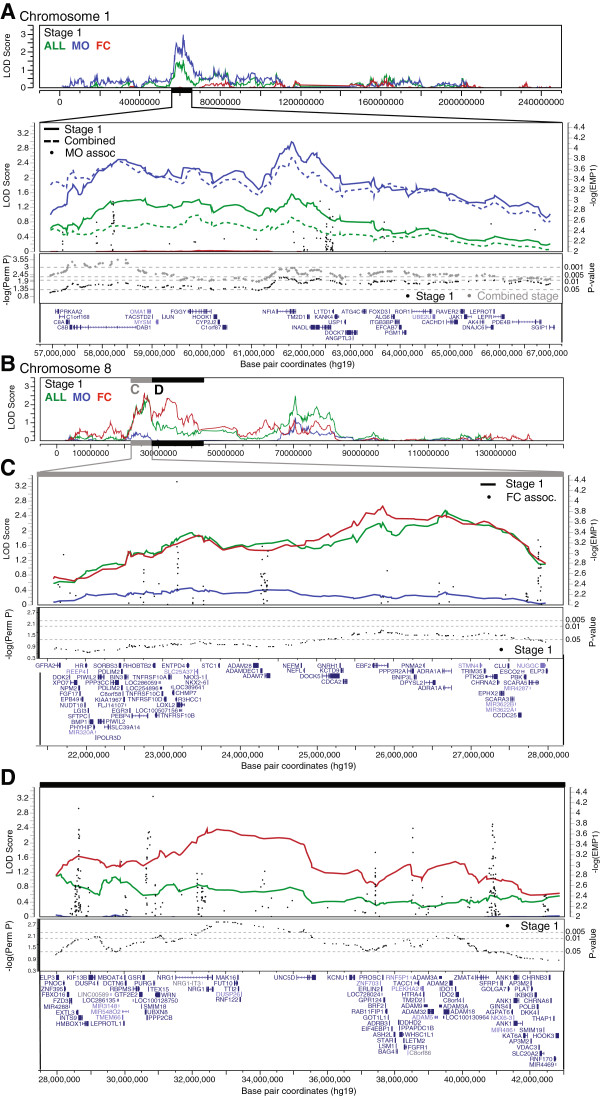
Significant sex-differential linkage peaks. Regions of sex subgroup-specific suggestive linkage (logarithm of odds (LOD) ≥2.2) with empirically significant signal enrichment from randomization testing are plotted. (A) 1p31.3, MO; top: linkage across full chromosome 1 from all stage 1 family groups; upper-middle: linkage from all stage 1 (solid lines) and combined sample (dashed lines) family groups and association signal from transmission disequilibrium test (TDT; black dots, EMP1 is empirical P-value from TDT) in male-only (MO) families across 2-LOD interval from peak LOD; lower-middle: empirical P-values from test of linkage subgroup specificity (black = stage 1, gray = combined), dotted lines indicate thresholds corresponding to empirical P-values of 0.05, 0.01, and 0.005; bottom: RefSeq gene alignment in 2-LOD interval. (B) Linkage across full chromosome 8 from all stage 1 family groups. (C) 8p21.2, female-containing (FC), (D) 8p12, FC; for each, top: linkage from all stage 1 family groups and TDT association in FC families across 2-LOD interval from peak LOD; middle: empirical P-values from stratification permutation tests; bottom, RefSeq gene alignment in 2-LOD interval.